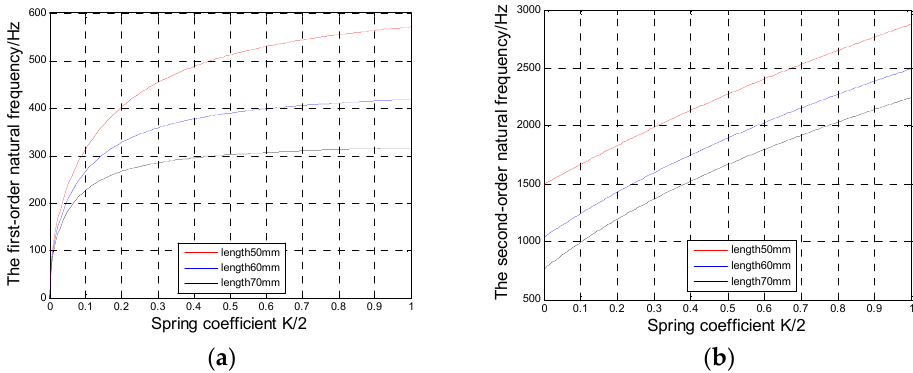
Figure 4. The natural frequency of the fiber laser’s the parameter changes. ( a ) the first-order natural frequency ( b ) the second-order natural frequency.